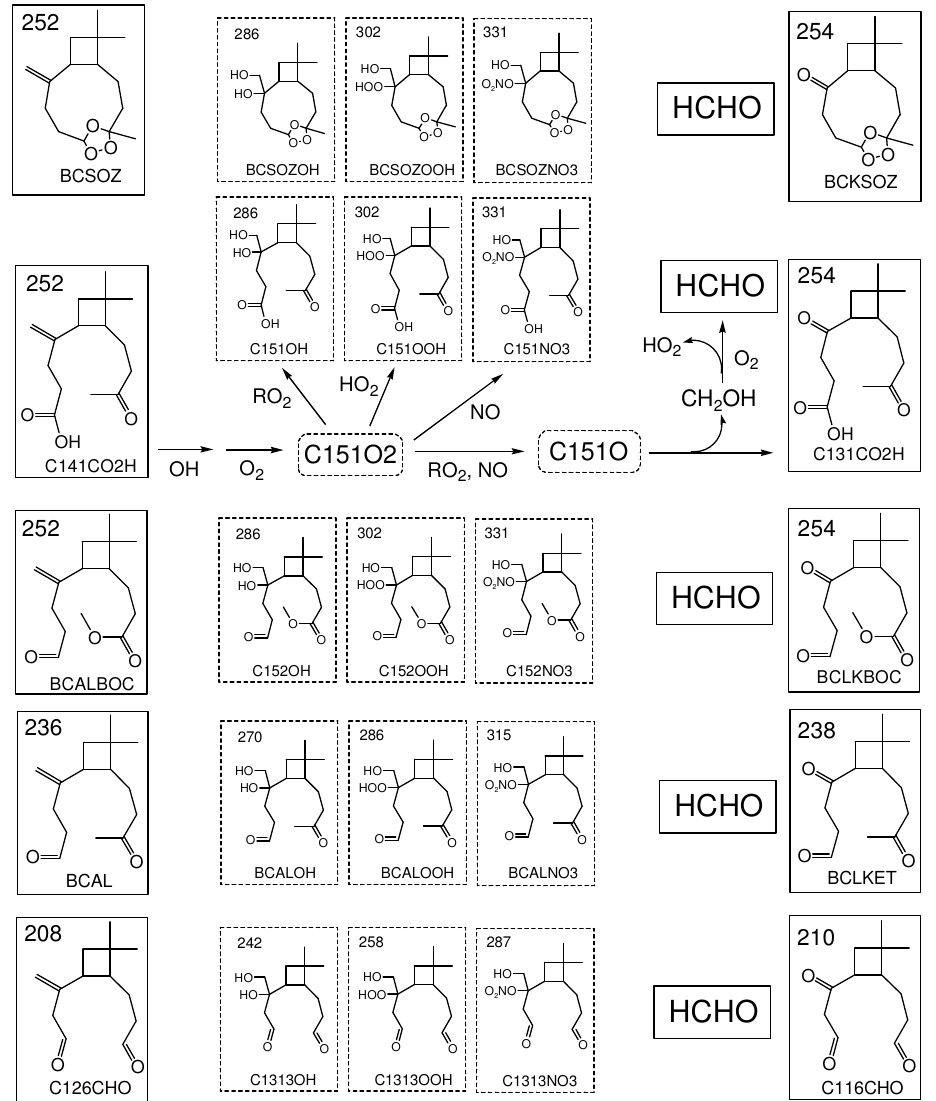
Fig. 7. Schematic of the mechanism and products of the OH-initiated oxidation of a series of first-generation products, shown in the left-hand column, following attack of OH at the residual “exocyclic” double bond. The details of the mechanism are summarised only for β -caryophyllonic acid (C141CO2H); but the mechanisms for the other species follow analogous pathways. The displayed values indicate the molecular masses of the products.